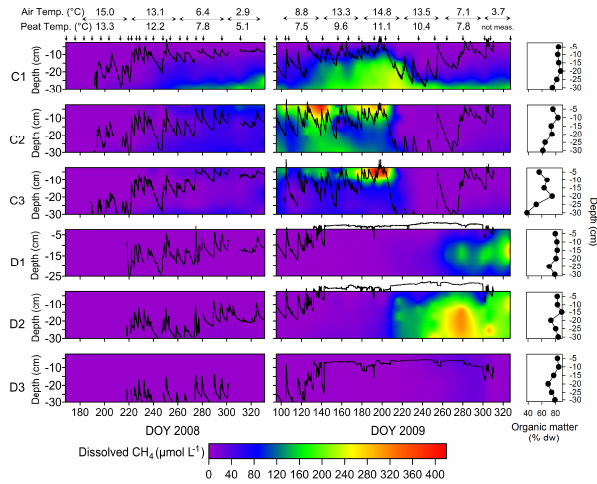
Fig. 4. Dissolved methane concentrations. Refer to caption in Fig. 2. Air and peat (5cm depth) temperature values are means of hourly measurements over periods of 40 days. The depth distribution of organic matter content in % dry weight is also shown.